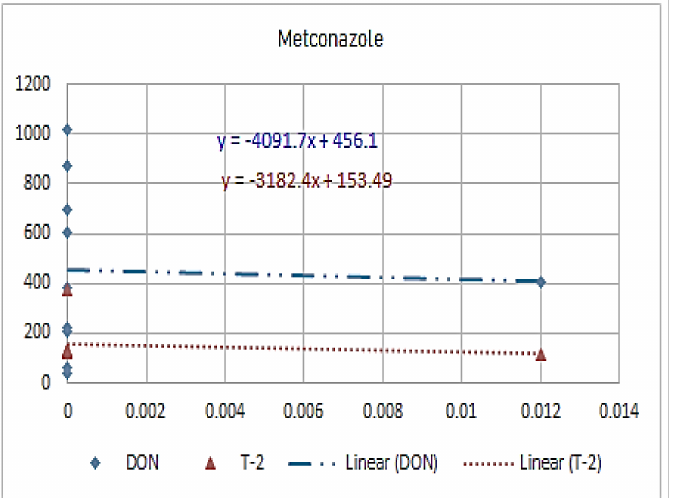
Figure 7. The relation between metaconazole residue (ppb) and DON and T-2 toxin (ppb) in wheat samples.